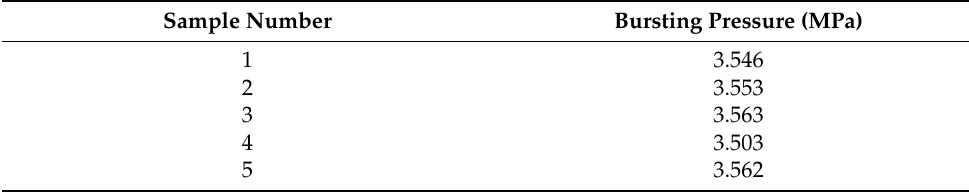
Table 2. Results of bursting